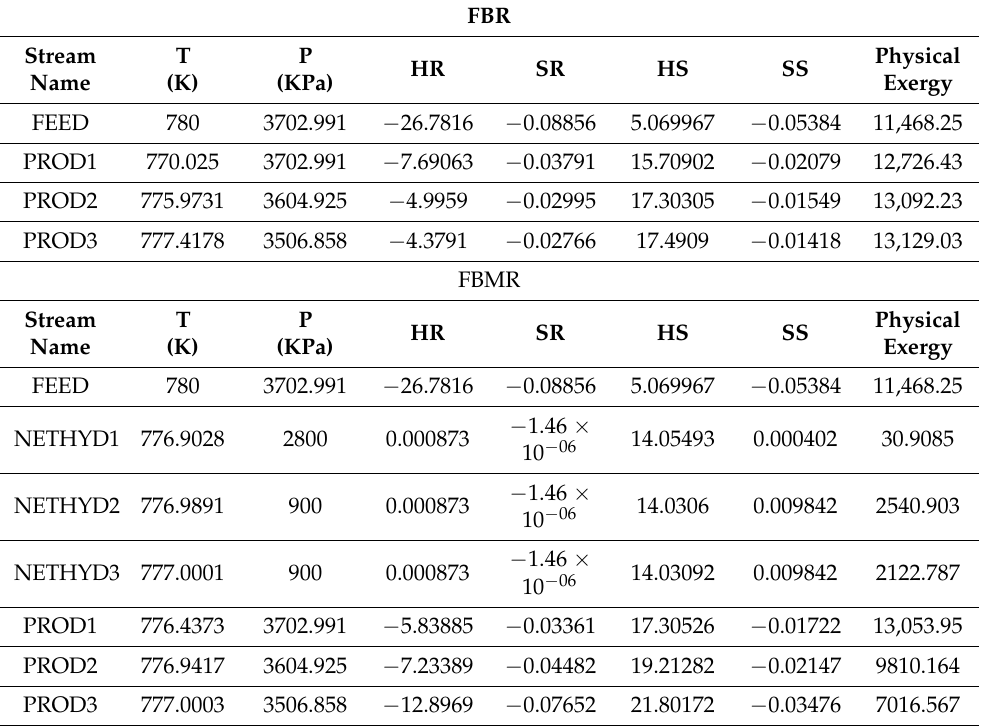
Table 6. Exergy analysis for FBR and FBMR.